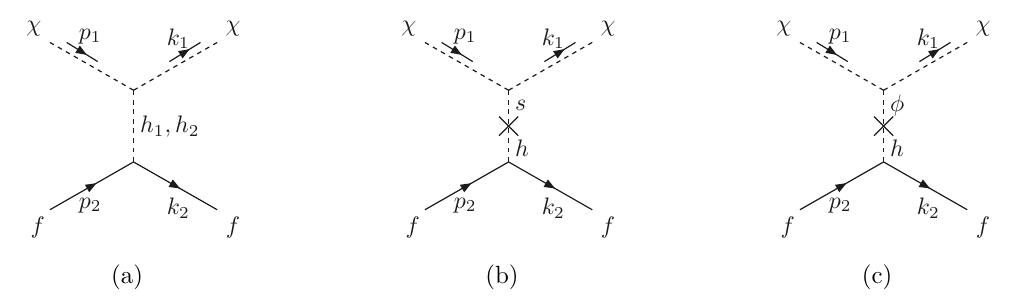
Figure 1. The three different points of view for the same DM- f (SM fermions) scattering process. Plot (a) represents two diagrams with different mass-eigenstate mediators which give rise to a miraculous cancellation. Plot (b) is the diagrammatic representation of our first proof, while Plot (c) is the perspective of our second